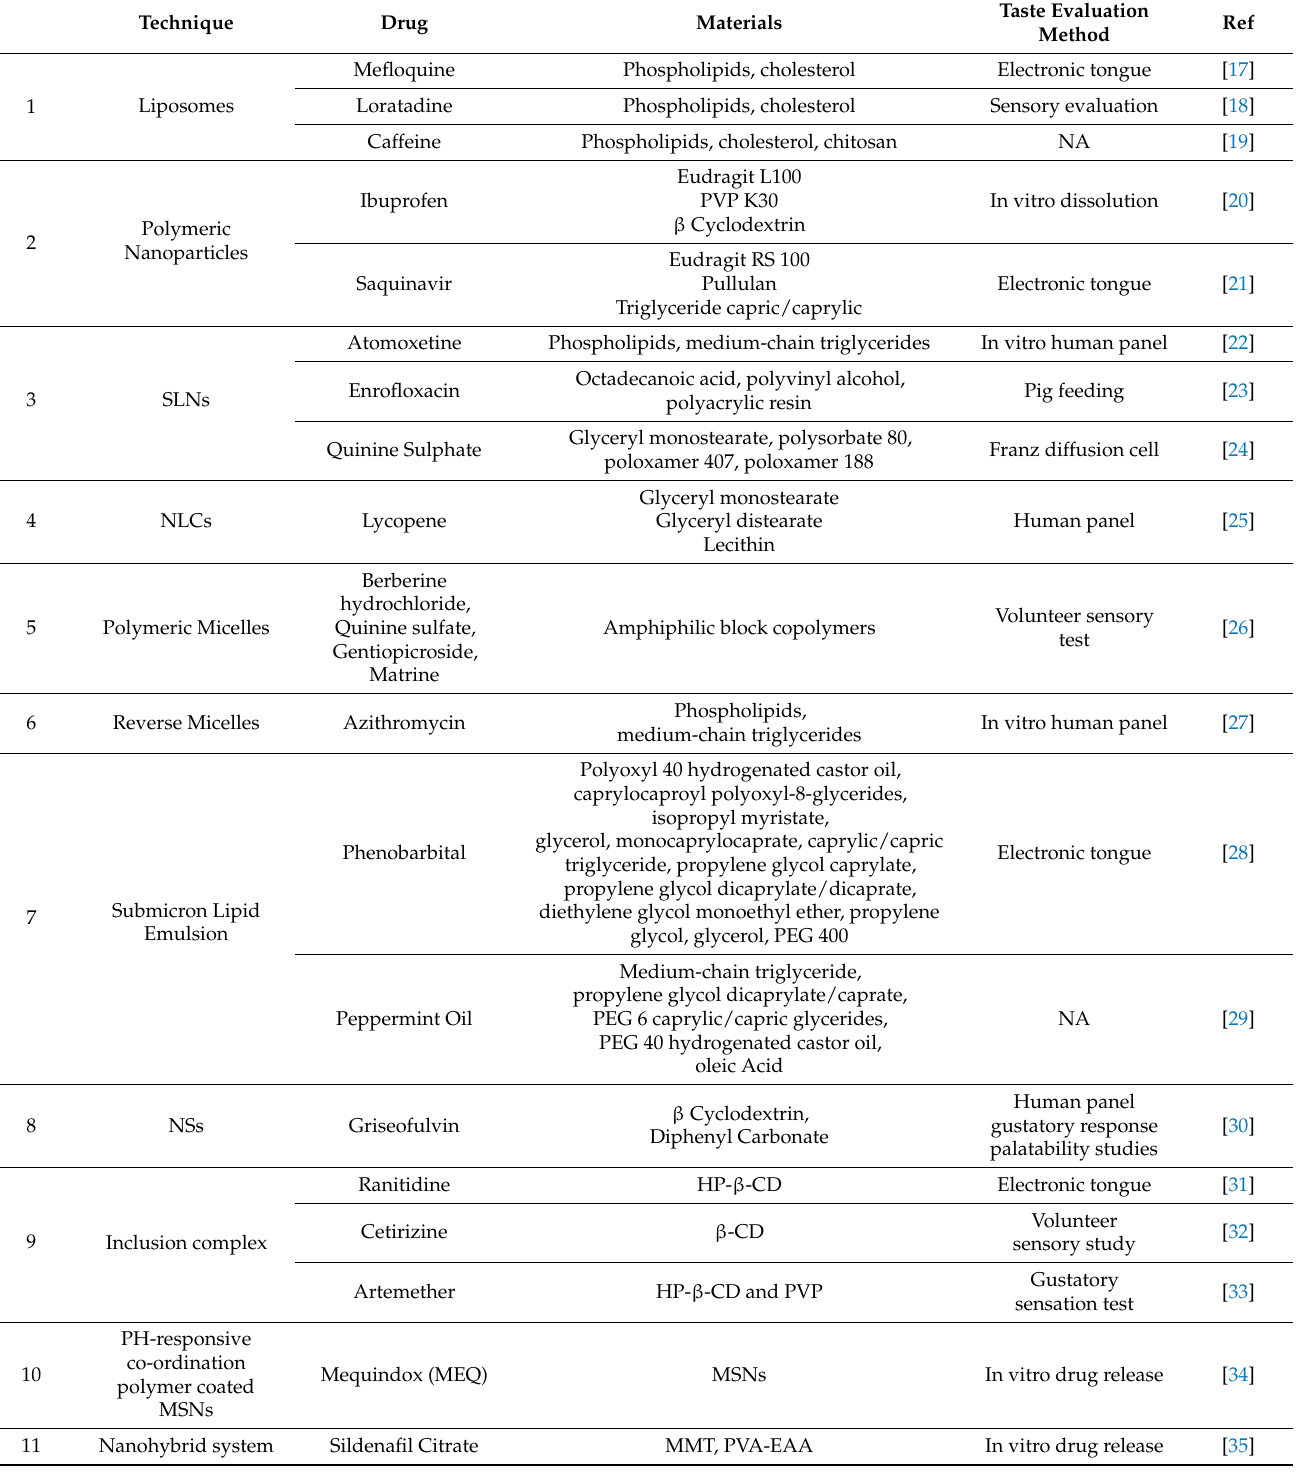
Table 2. Nanocarrier systems formulated to mask the taste of different